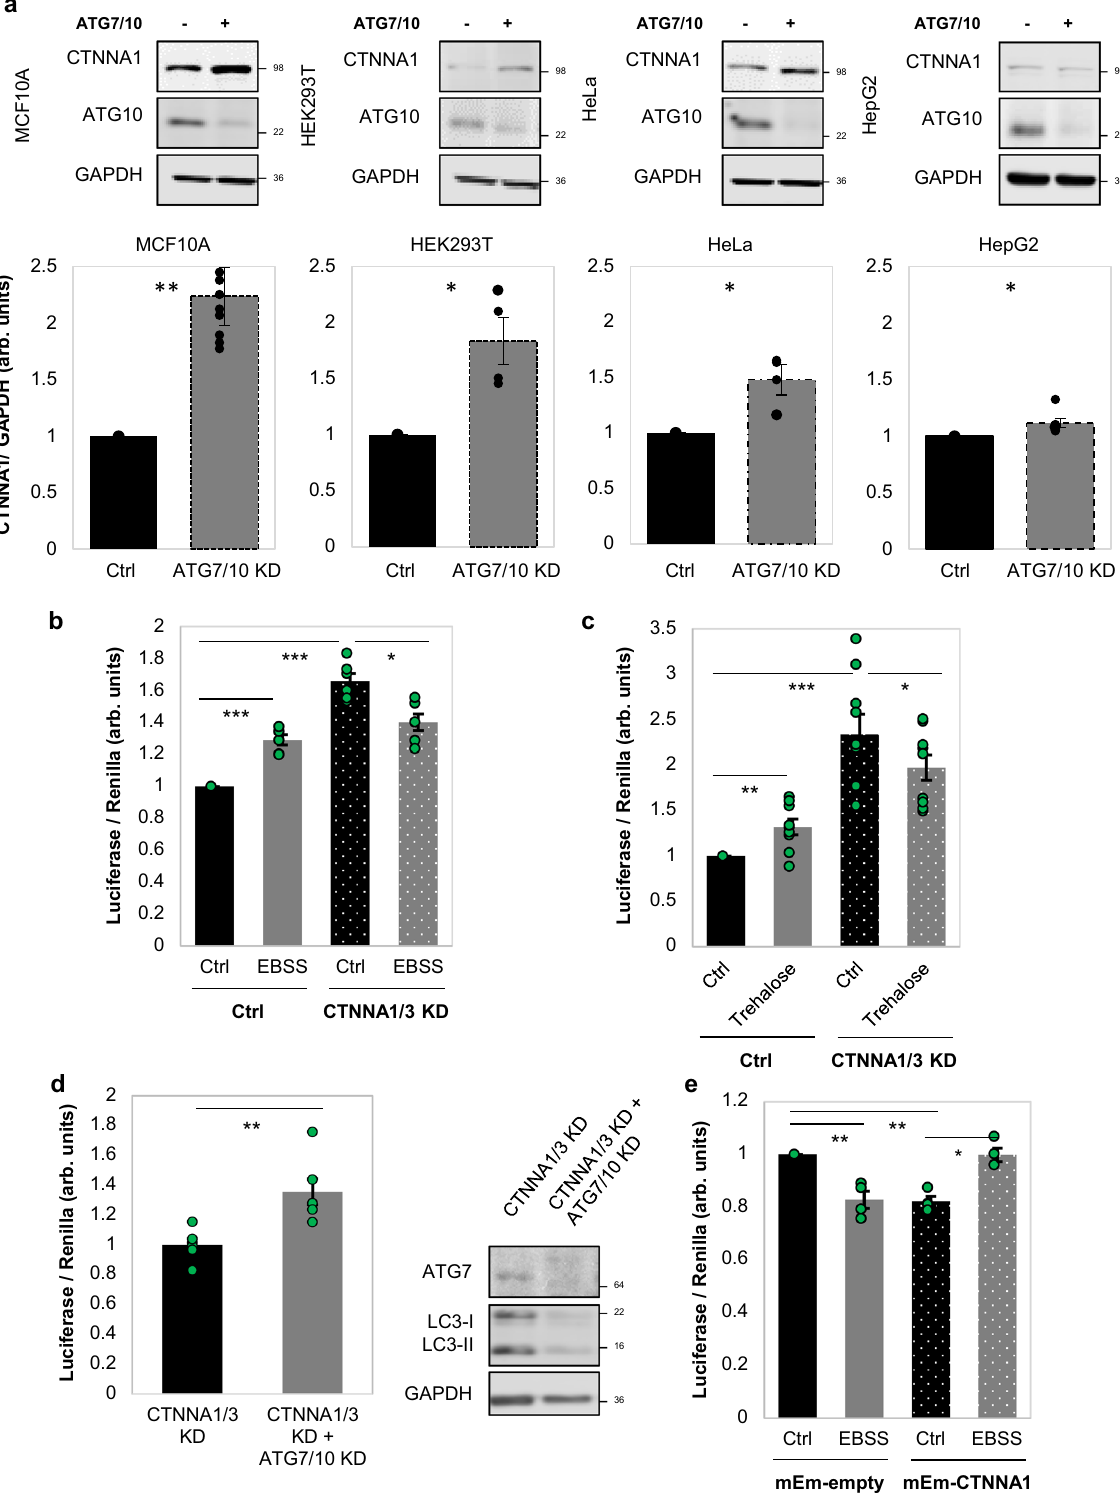
protein revealing). The graphs show the mean of independent experiments. One sample t -test (when the control was initially set up to 100 %), two-tailed Student ’ s t -test, two-way ANOVA, chi-squared test and multinomial logistic regression were used to quantify P values in Origin v8.1 or SPSS Statistics v25.0. The statistical details of all experiments (including n numbers, error bars, P value statistical signi fi cance and the statistical test performed) are reported in the fi gure legends. The colocalization Mander ’ s and Pearson ’ s coef fi cients were analysed using both ImageJ and Volocity softwares. Those experiments were examined